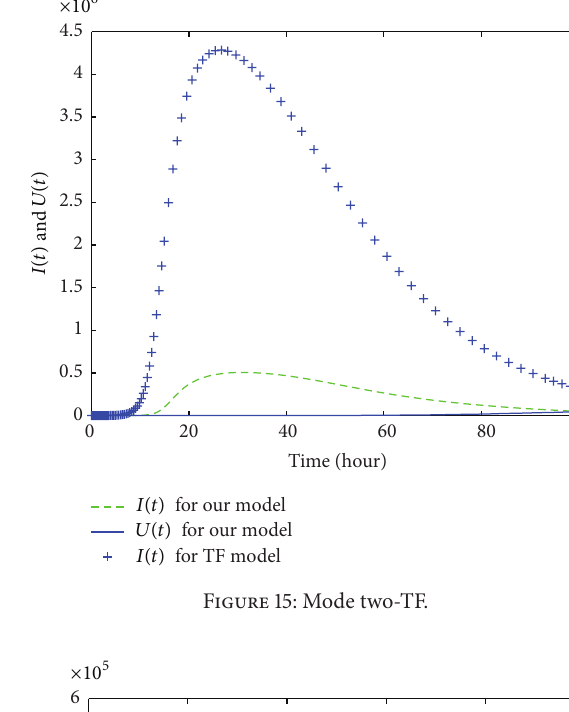
Figure 13: Mode one-TF.